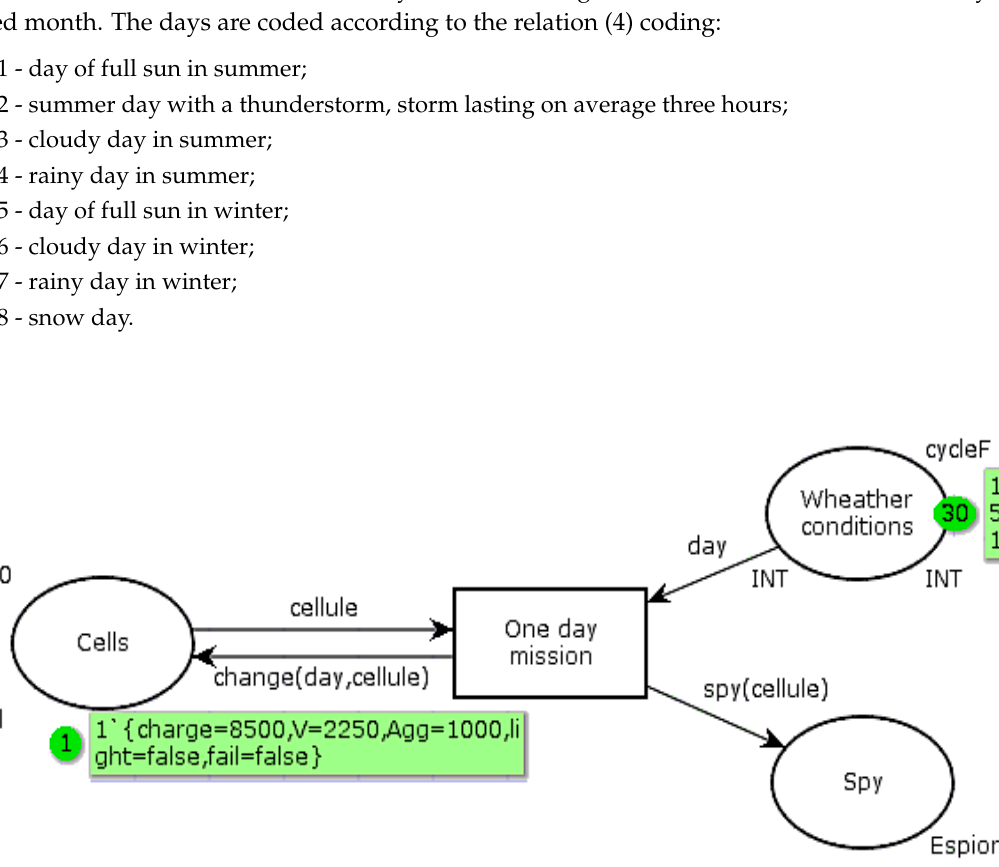
Figure 7. PN simulating the daily operation and listing the selected parameters.